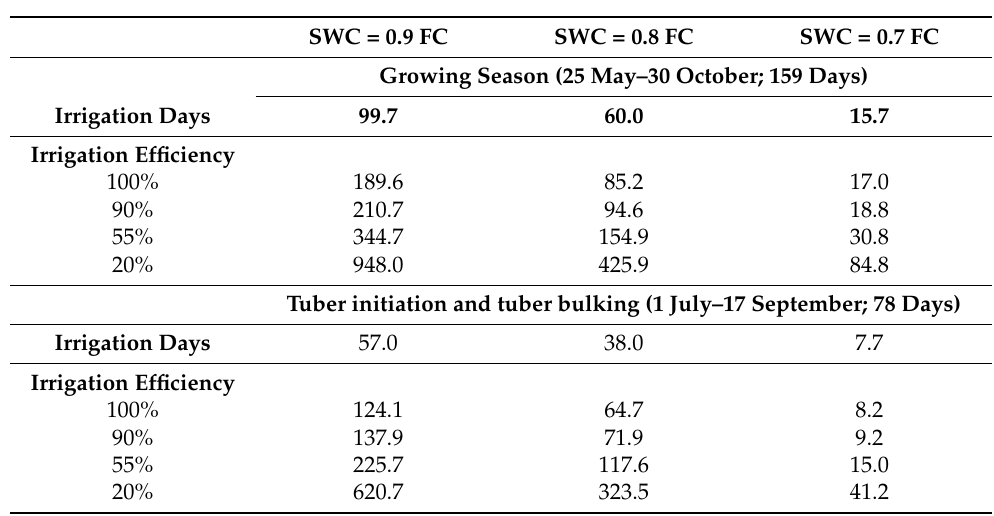
Table 2. Irrigation requirements (mm) for the growing season and tuber initiation and bulking stages based on multi-year daily averages for the study period (2010–2019).